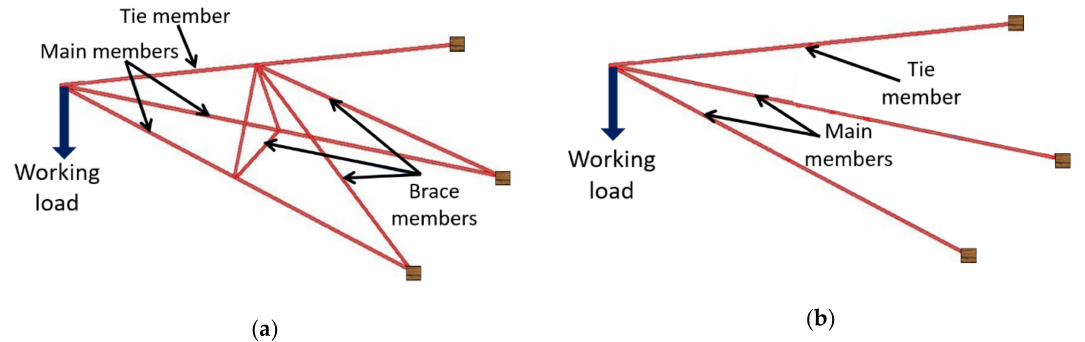
Figure 2. Cross-armconfigurations: ( a )withadditionalbracingarms—braceddesign; and( b )withoutbracingarms—current design.